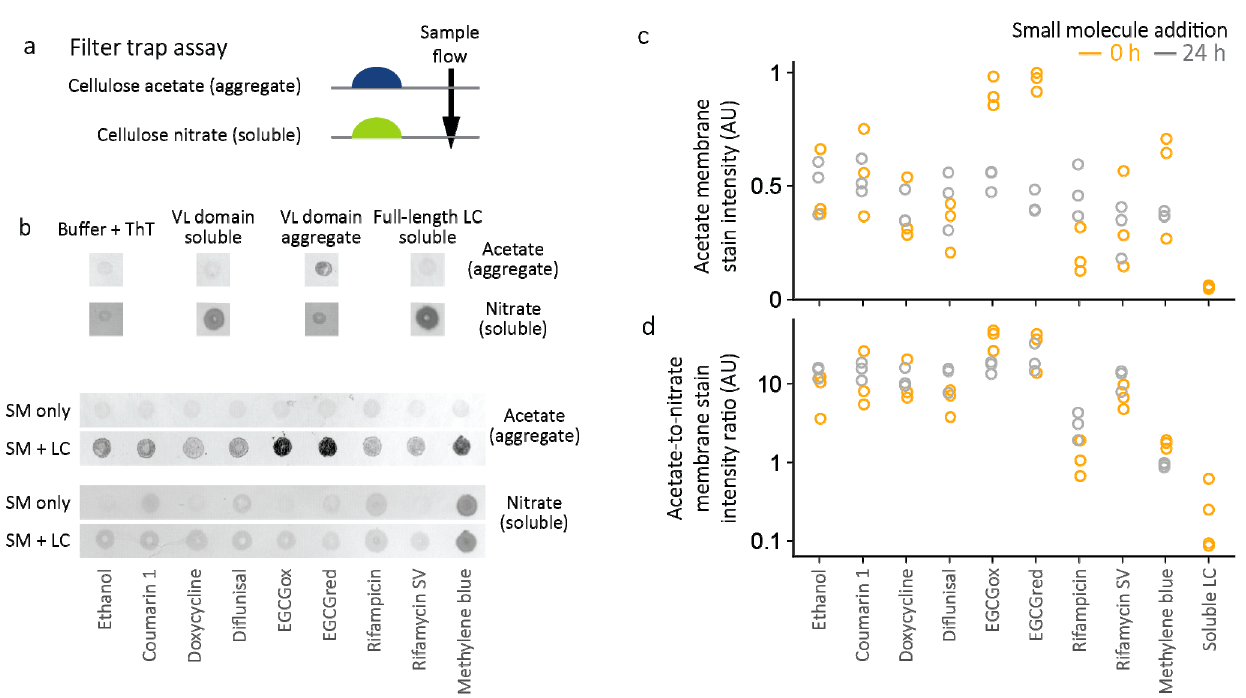
Figure 8. Quantitation of soluble and aggregated LCs by the filter trap assay. Fibril formation was monitored by ThT fluorescence as described in Figure 6. ( a ) Schematic diagram of the filter trap assay. Soluble proteins pass through the cellulose acetate membrane and bind to the cellulose nitrate membrane. ( b ) Examples of stained membranes. Control samples (top) show the staining of soluble or aggregated LCs on cellulose acetate or cellulose nitrate membranes. Two types of soluble LCs were used as negative controls for aggregation: JTO-V L that had not been incubated at 37 °C and full-length JTO that did not aggregate over the course of the experiment. Note that several small molecules, especially methylene blue, stain the membranes in the absence of protein, which affects their apparent quantitation. ( c ) Aggregate load is estimated by quantitation of the cellulose acetate membrane staining, relative to the most intense sample. Orange points represent wells where small molecules were present throughout the aggregation process, and grey points repre- sent wells where the small molecules were added after aggregation had occurred. ( d ) The ratios of aggregated to soluble LCs are shown for each individual sample. Symbols are colored as for panel ( c ).